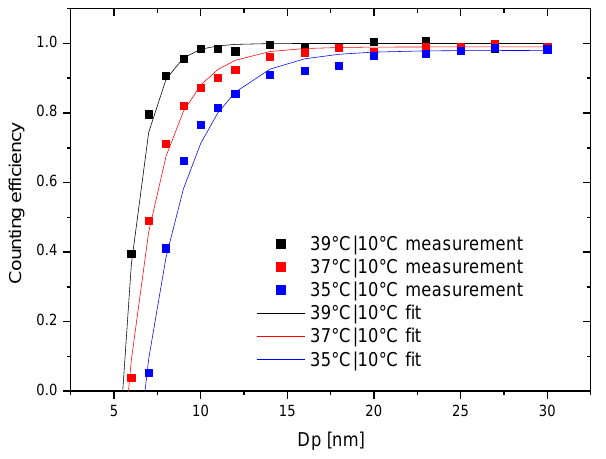
Fig. 3. Counting efficiency of the Fast CPC at different temperature differences and different aerosol flows compared to the electrometer (TSI 3068B) for selected particle diameters. The total flow (satura- tor+aerosol flow) was kept constant at 1lmin − 1 . Squares present the mean measurement points, the error bars the standard deviation. Table 1. Fit parameters a , D 1 and D 2 for Eq. (1) as well as the 50% detection diameter D P50 of the mean FCPC counting effi- ciency curves as presented in Fig.